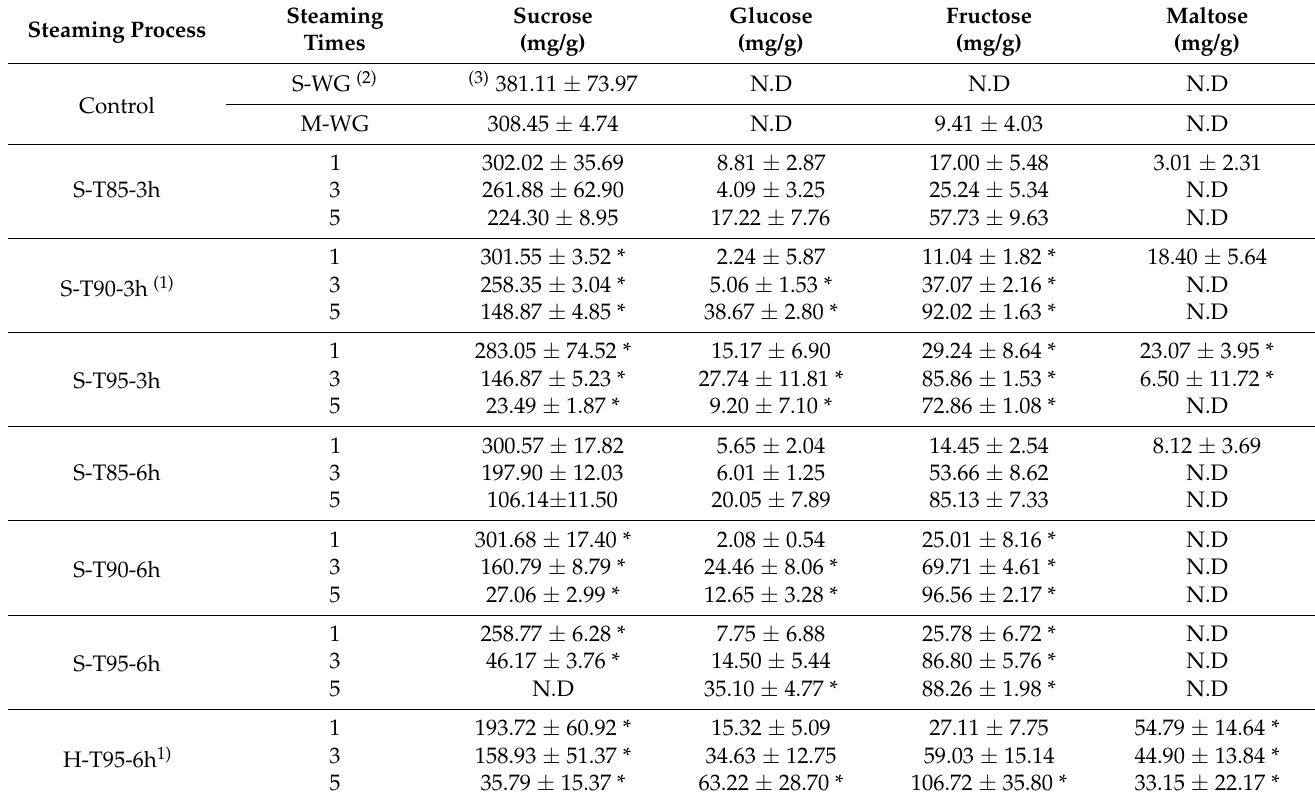
Table 2. Free sugar content of stored and harvested